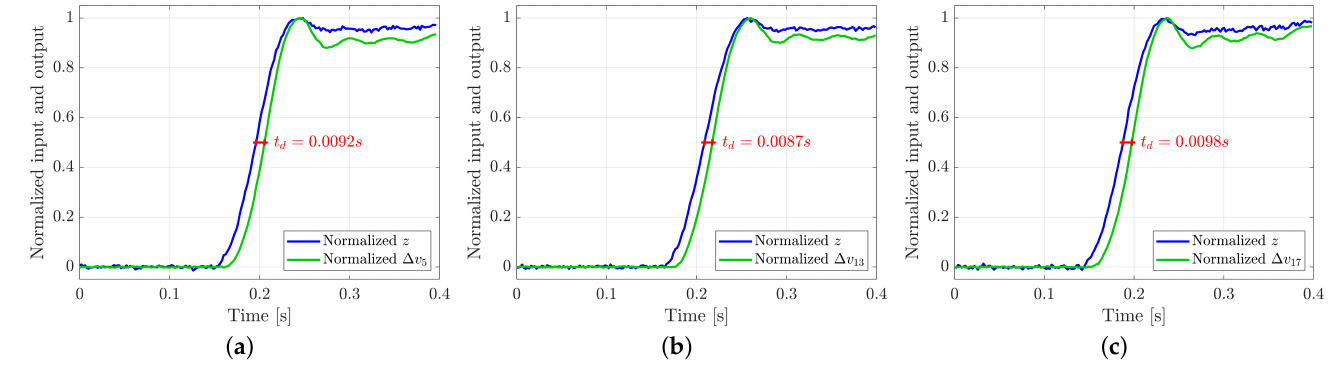
Figure 12. Response time graphs for taxel 5 ( a ), taxel 13 ( b ) and taxel 17 ( c ). Signal-to-Noise ratio . The power spectrum of the voltage signals for the three taxels have been computed to evaluate the SNR. The results for the three taxels are reported in Figure 13 where it is possible to see that, since the bandwidth of the signals of interest is limited to few hertz, the noise level is about 5–6 order of magnitude below the signal level. The optimal result in terms of SNR is mainly due to the current driven solution implemented for the LED.